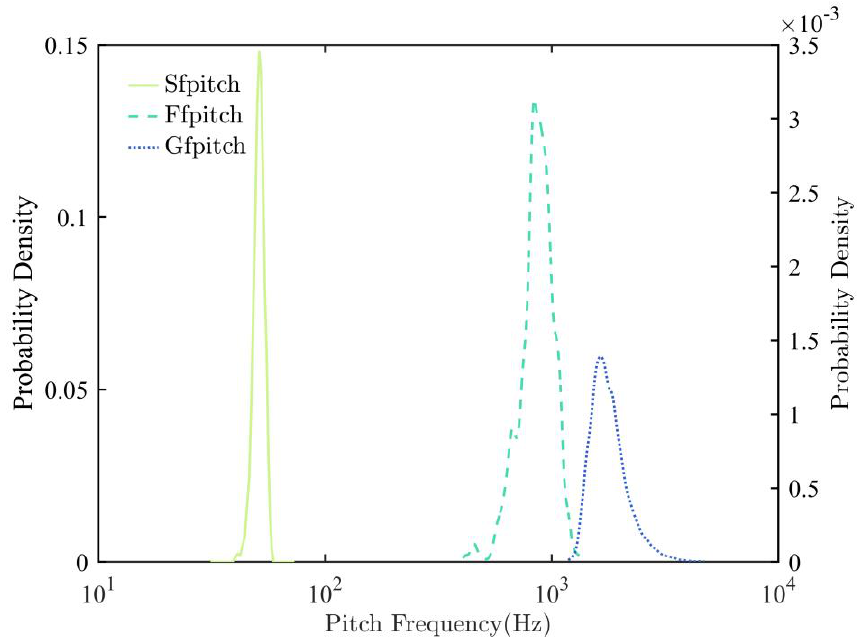
Figure 10. Probability density distribution curve of pitch frequency 𝑓 𝑝𝑖𝑡𝑐ℎ for three types of acoustic signals. (The preliminary calculations are obtained by randomly extracting the audio signal fragments from the original audio signal to use as analysis samples. The curves in the image are plotted by smoothing the results of the preliminary calculations to concentrate the distribution.)